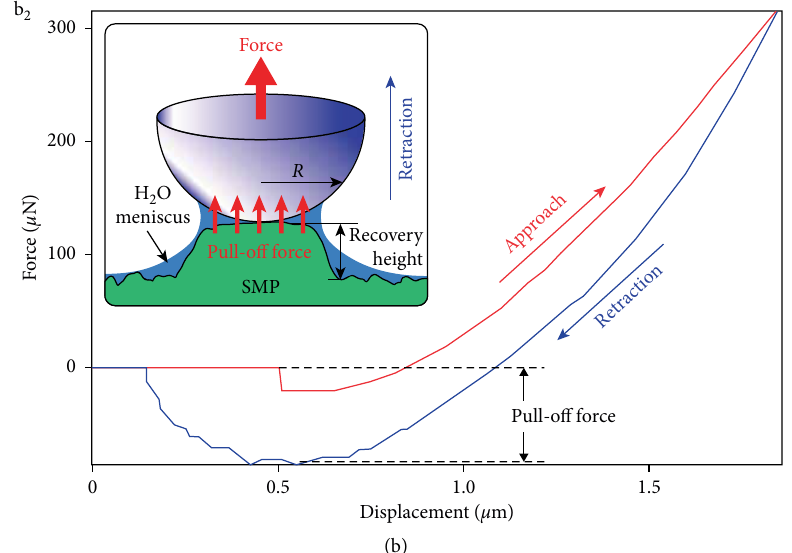
Figure 7: (a ) Printing process of invisible photonic patterns shown by deformation, adapted from [177] and (a 1 ) Arbitrary photonic crystal patterns printed on the new SMP membranes and (b from [178]. (b 1 forces. Adapted from